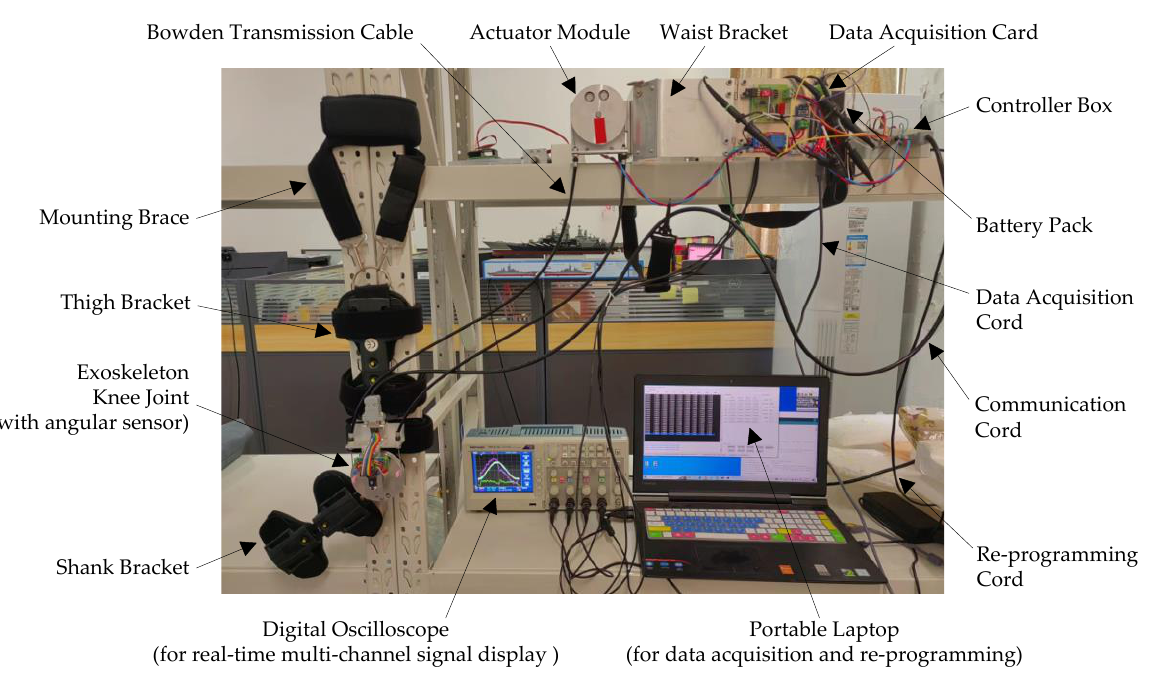
Figure 12. Experimental setup to test the learning-based repetitive controller for the soft knee exoskeleton with nonlinear friction and backlash of the Bowden transmission cables.